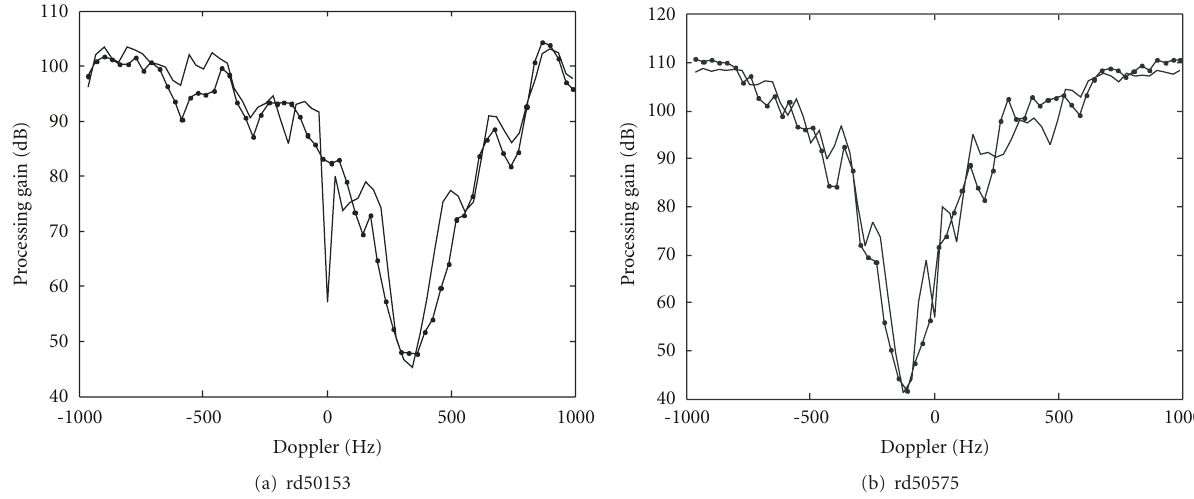
Figure 9: Processing gain across all Doppler bins when scanned to array broadside (angle index = 65). •− MTR solution, — Reduced STAP.